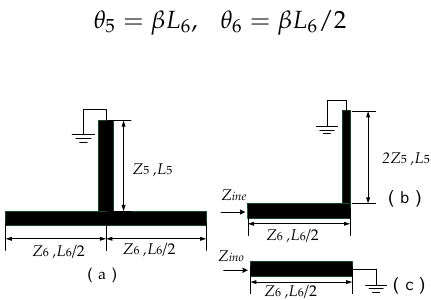
Figure 4. ( a ) The structure of T-shaped resonator; ( b ) even-mode equivalent circuit; ( c ) odd-mode equivalent circuit ( Z 5 and Z 6 are the characteristic impedance. L 5 and L 6 /2 are length of the open-circuited stub and the short-circuited stub).